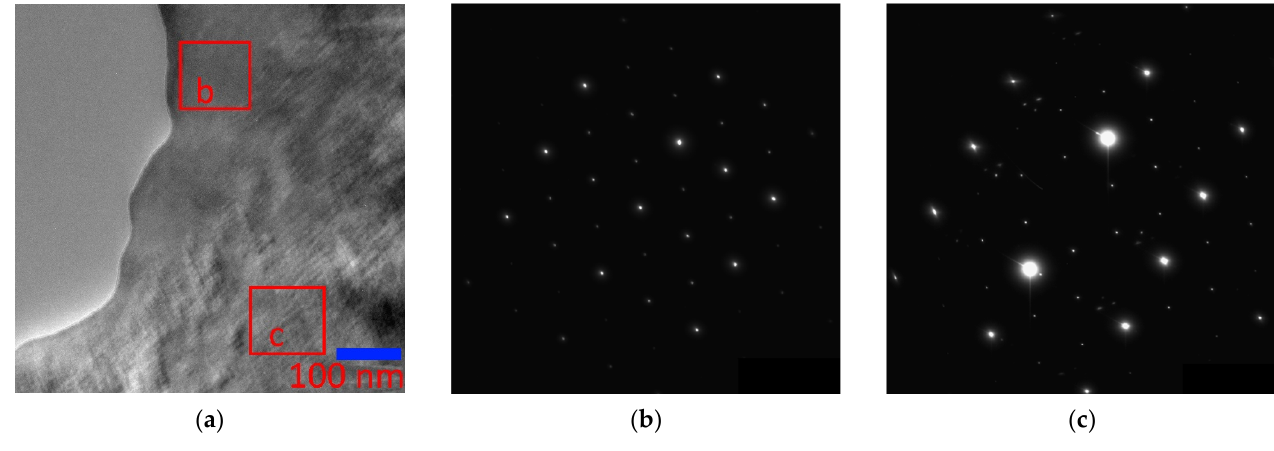
Figure 4. Micrograph of the Ni 46 Mn 41 In 13 alloy ( a ) and microdiffraction patterns ( b , c ) from regions with different structures.